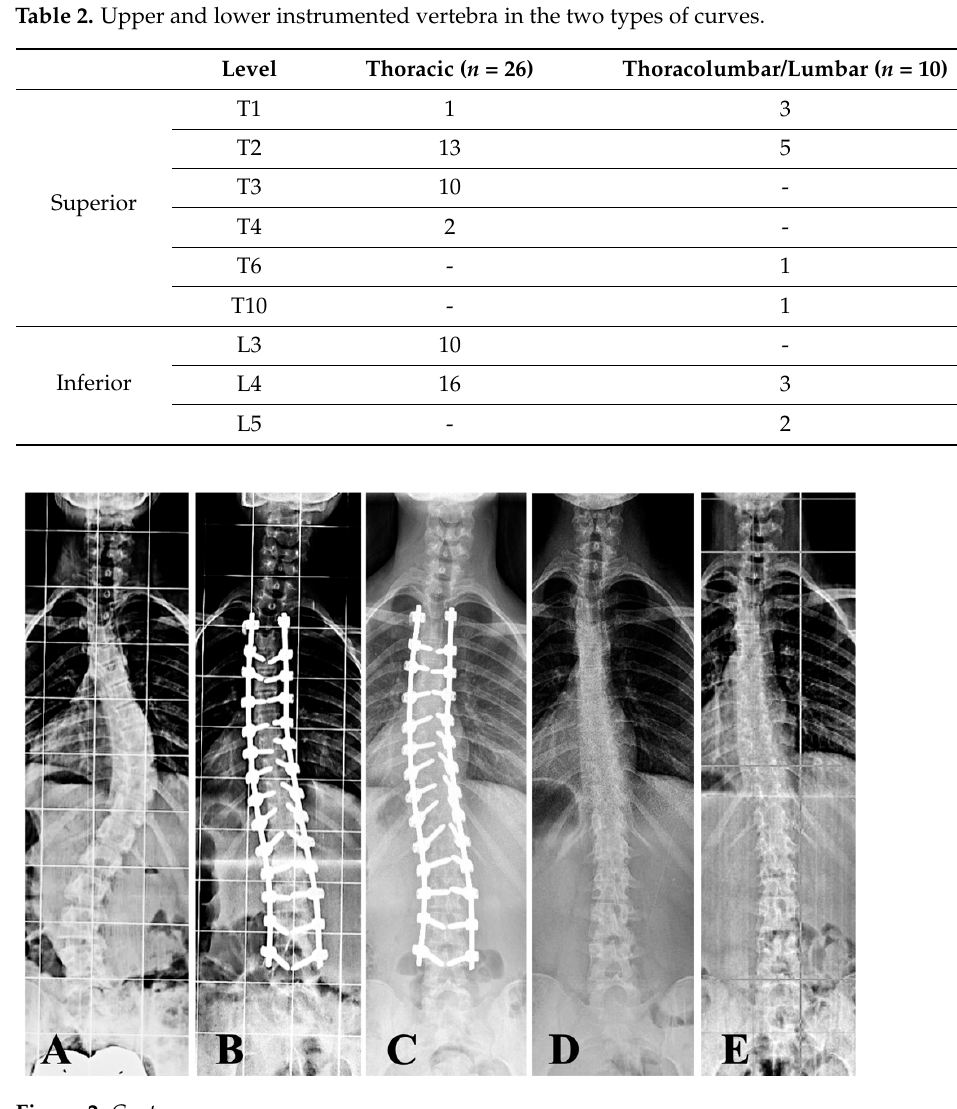
Figure 2. A 13-year-and-2-month-old girl with Lenke type 1BN AIS (50°/36°) with Risser 1 ( A ) and thoracic hypokyphosis of 13° ( F ), was surgically treated by a posterior approach involving T3-L4 instrumentation without fusion with slight hypercorrection of both curves ( B ). Three years and two months after the initial surgical intervention and just before the removal of instrumentation, the main and compensatory curves remained unchanged towards the opposite side of the initial curves ( C ). The radiograph after removal of the vertebral implants shows minimal residual scoliosis to- wards the opposite side of the curves that existed before surgical treatment ( D ). These minimal sco- liotic curves remained unchanged on the last radiograph, taken two years after the removal of the instrumentation ( E ). Concerning the sagi tt al plane, the postoperative radiograph after surgical cor- rection demonstrated an increase in previous hypokyphosis ( G ), which remained unchanged in the radiograph prior to removal of the instrumentation ( H ), after its removal ( I ), and in the last X-ray check-up two years after instrument removal ( J ).